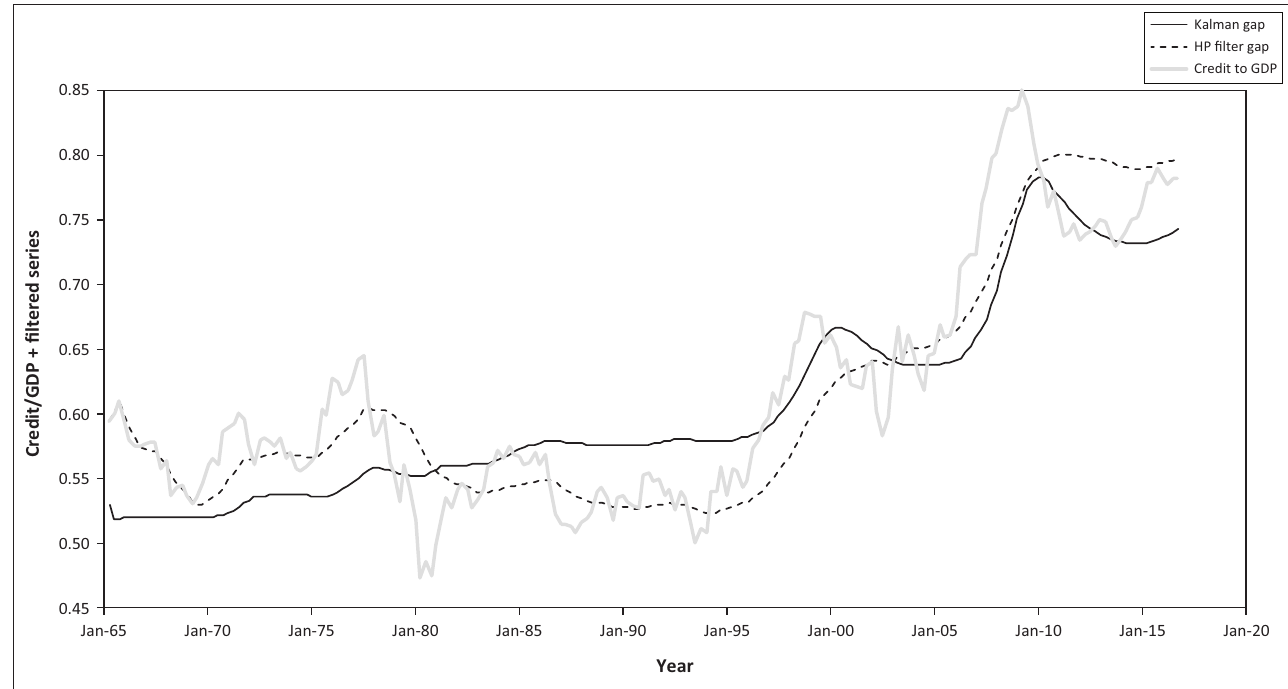
FIGURE 2: South African credit-to-GDP, Hodrick–Prescott-filtered ( λ = 144 000) and Kalman-filtered